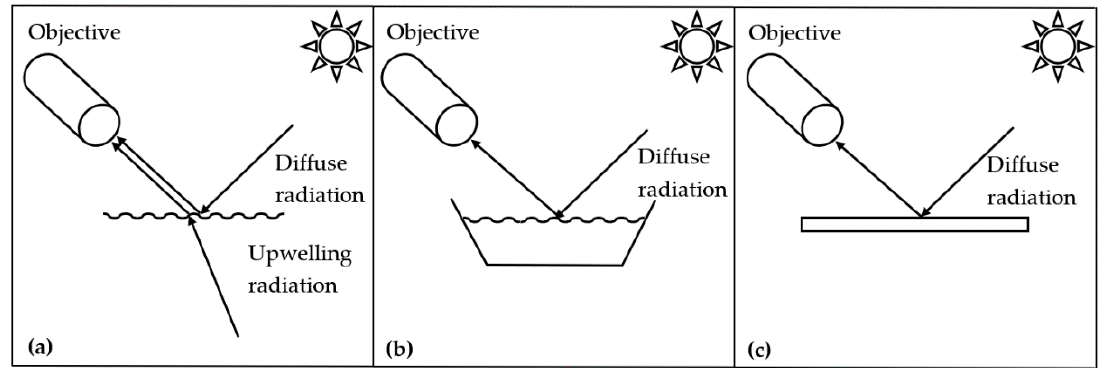
Figure 2. The spectrometer on board R/V “Academik Ioffe”.